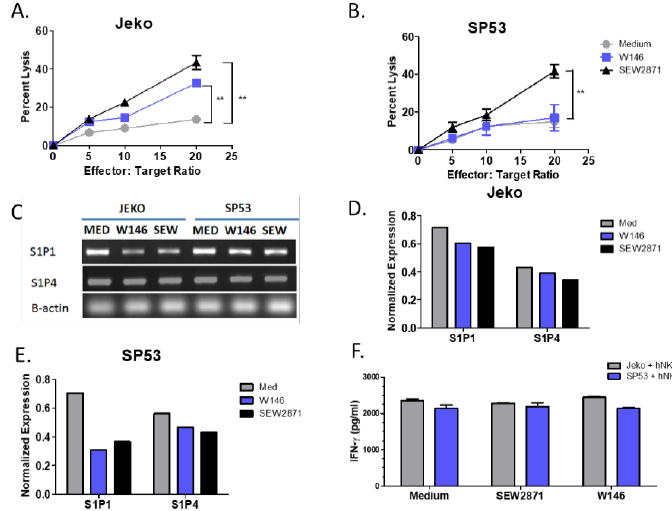
Figure 1. Pretreatment with S1P inhibits CD1d-mediated NKT cell activation. ( A ) S1P levels in healthy donor and MCL patient sera were measured using ELISA. ( B ) NKT cells (DN32.D3) and B cell lymphomas (C1R-CD1d) were pretreated with vehicle (DMSO) or S1P (1 μg/mL) for 1 h at 37 °C. DN32.D3 (5 × 10 4 ) NKT cell hybridomas were incubated with C1R-CD1d cells (2.5 × 10 5 ) in the presence of α-GalCer (100 ng/mL) for 20–24 h. ELISA was used to measure IL-2 production. Data was analyzed by a two-tailed t-test with Welch’s correction. * p < 0.05.